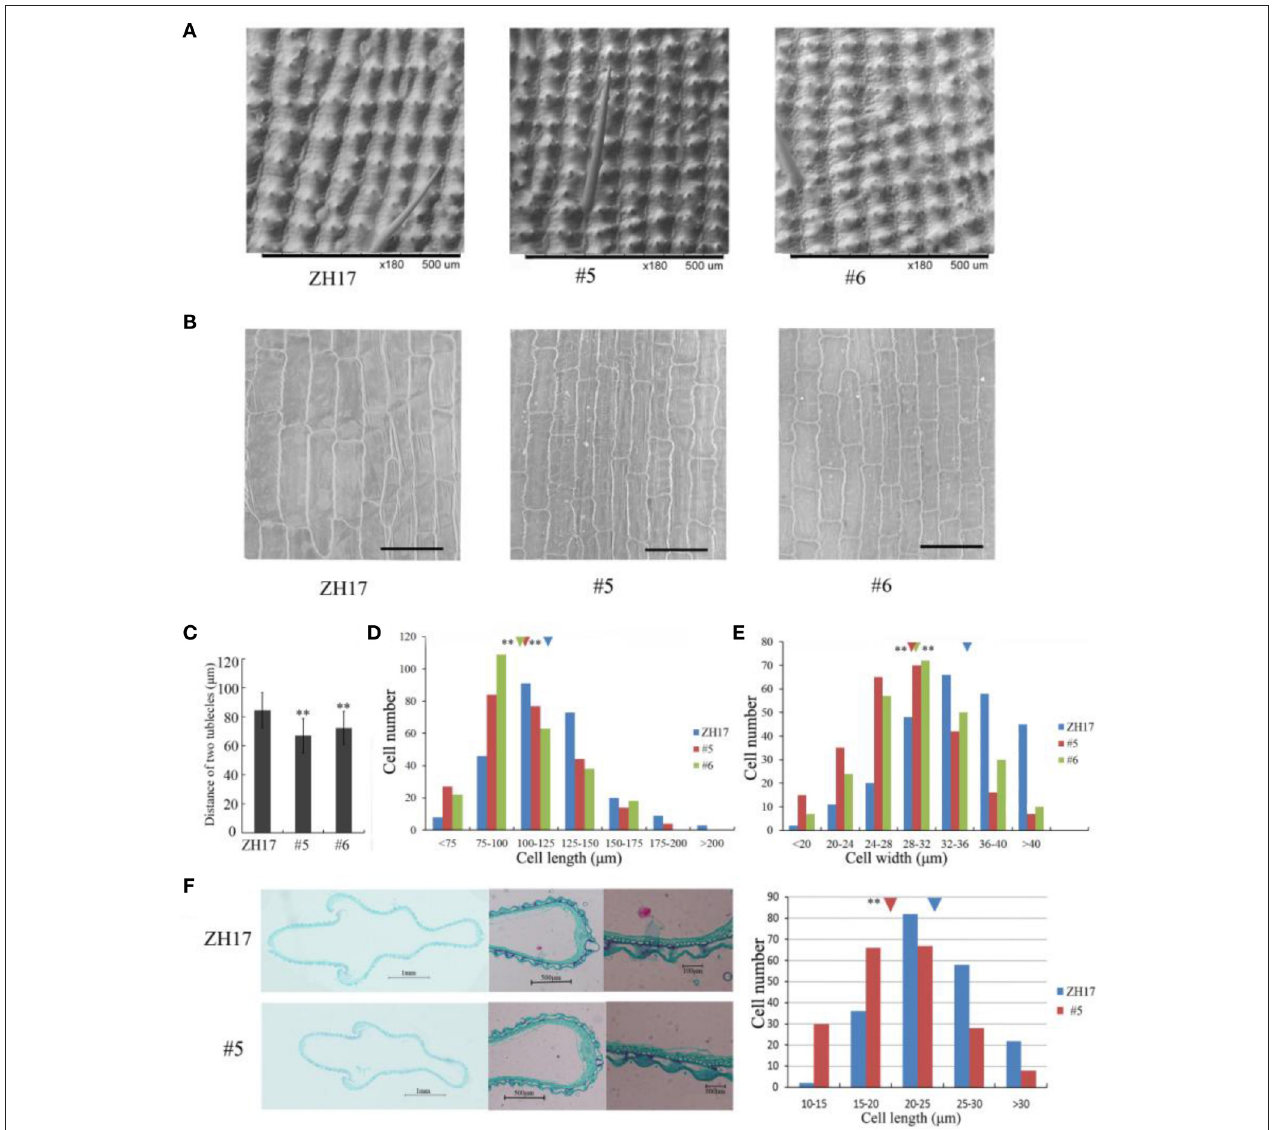
FIGURE 7 | Scanning electron microscopy analysis of OsCEP6.1 overexpression lines and the control. (A) Scanning electron microscopy analysis revealed that the distance between two adjacent tubercles on the outer spikelet hull surface was significantly shortened compared with the control (ZH17). Bar = 100 µ m, × 180. (B) Scanning electron microscopy observation showed that the size of the lemma inner epidermal cell is smaller in the transgenic line than that in the control. Bar = 100 µ m, × 250. (C–E) Statistical analysis of the distance between two adjacent tubercles ( n = 200 ), cell length ( n = 250 ) and cell width ( n = 250 ) showed that all of them were significantly reduced by the overexpression of OsCEP6.1 . The inverted triangles present the average cell length and width, the values are means ± SD. **Indicates significance of cell length and width between the transgenic line and the control at the P = 0.01 level. (F) Histological analyses showed that the cell length of the outer parenchymal cell layers of the spikelet hulls is significantly larger in ZH17 than in the transgenic line. Blue and red inverted triangles show the average cell width of ZH17 and transgenic line (#5), respectively, and the values are means ± SD ( n = 200 ), ** P < 0.01